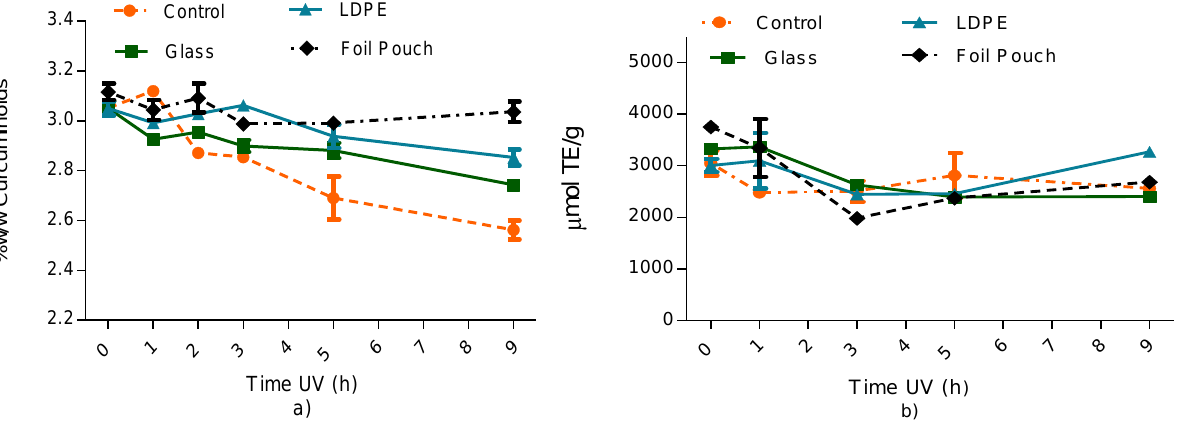
Figure 4. Effect of UV radiation on curcuminoid content using different packaging materials for turmeric powder. ( a ) Variation of curcuminoid content vs. time. ( b ) variation of the antioxidant capacity of the powder vs. time.